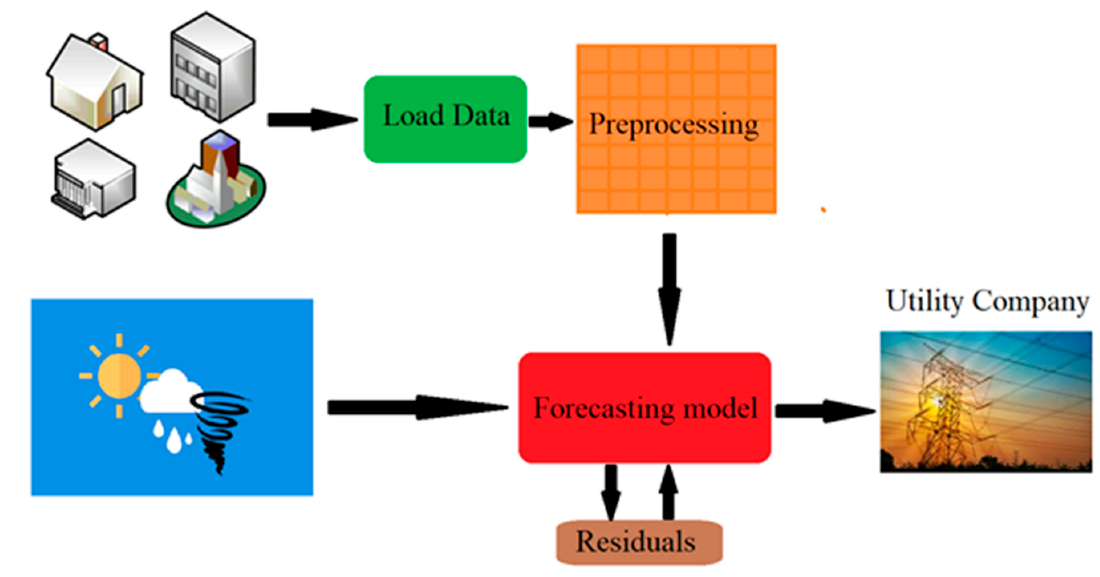
Figure 1. Schematic flow of the proposed method.